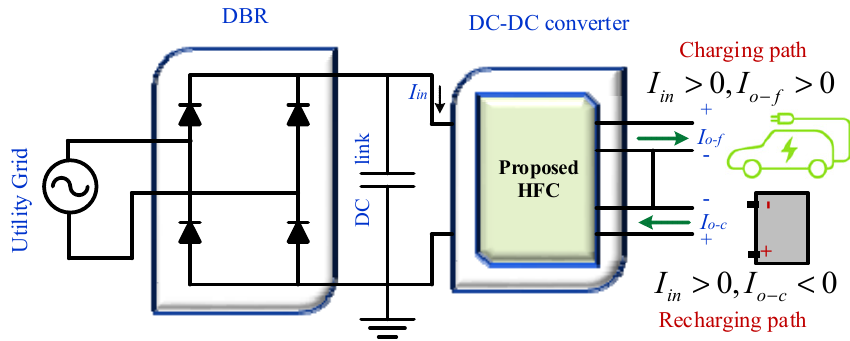
Figure 12. Structure of the EV adapter-connected HFC.